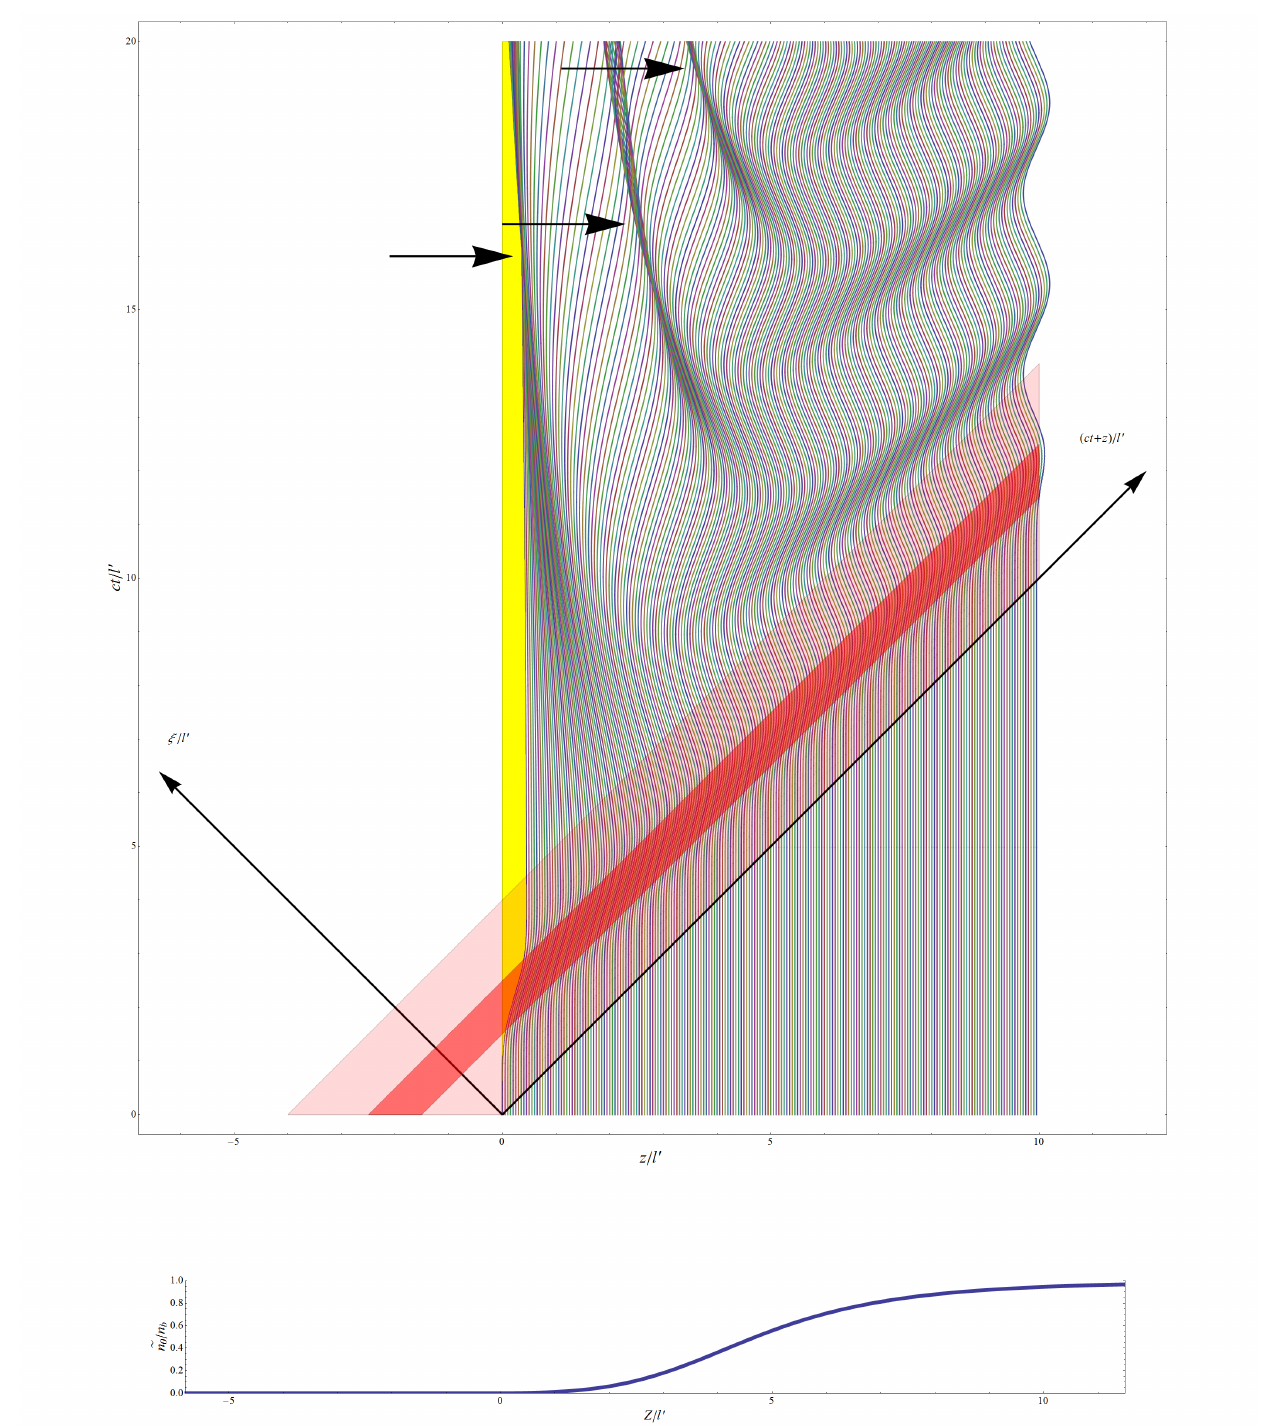
Figure 8. Down : The initial electron density (4) of Figure 2. Up : The worldlines of Z -electrons interacting with the pulse in Figure 1 for 200 equidistant values of Z ; the support 0 ≤ ct − z ≤ l and the ’effective support’ ( l − l (cid:48) ) /2 ≤ ct − z ≤ ( l + l (cid:48) ) /2 of the pulse are pink and red, respectively, while the spacetime region of the pure-ion layer is yellow. Horizontal arrows pinpoint where particular subsets of worldlines first intersect; as can be seen, small Z worldlines first intersect quite farther from the laser–plasma interaction spacetime region (shown in pink) than in the linear homogenous case